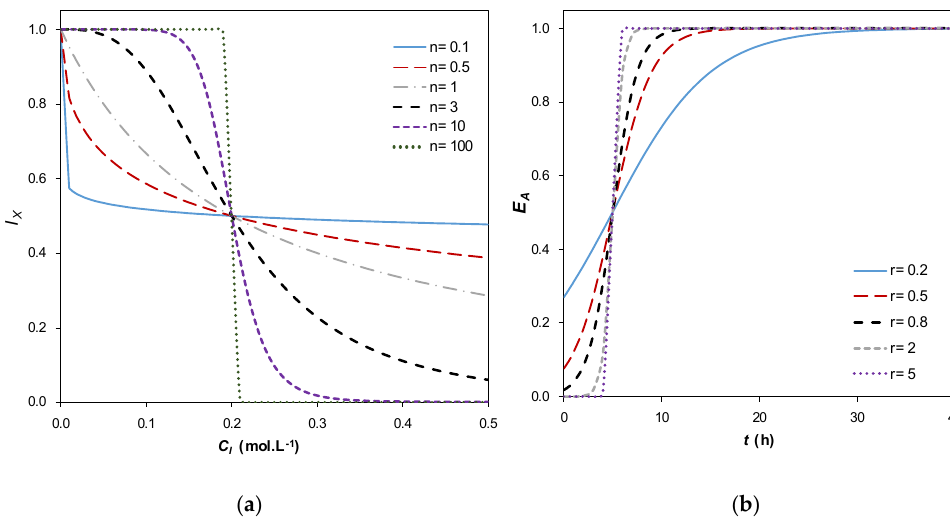
Figure 3. ( a ) Example of inhibition factor I X as a function of C I for different n values and K IX = 0.2 mol L − 1 . ( b ) Example of enzymatic activation factor E A as a function of t for different r values, and t lag = 5 h.